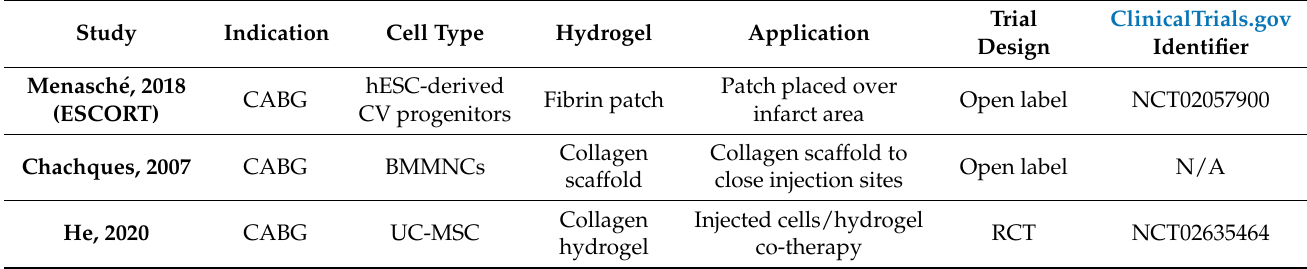
Table 1. Clinical trials using hydrogel delivery of cell